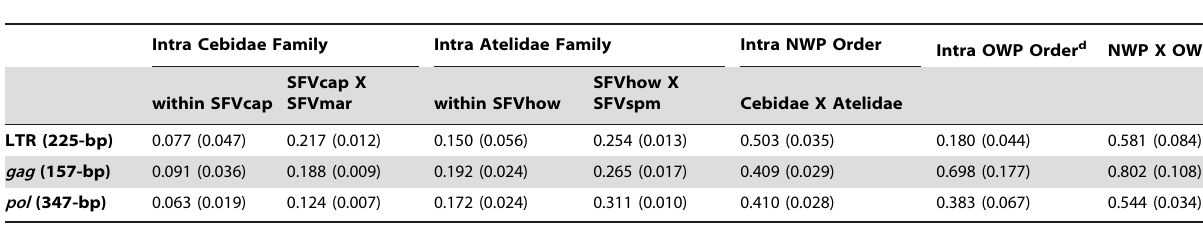
Table 3. Intra- and inter-primate family and order SFV nucleotide diversity a,b,c